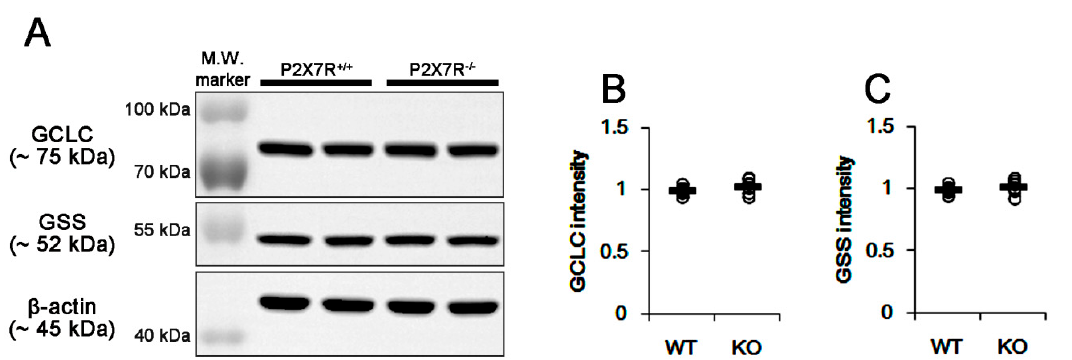
Figure 2. GSH assay in the hippocampus. P2X7R deletion decreases basal GSH level. NAC increases GSH level in WT animals but not P2X7R KO mice in vivo. Although SIN-1 does not affect GSH level in the hippocampal slices of both animals, it reduces GSH concentration to a basal level in NAC-treated WT animals but not P2X7R KO mice, ex vivo (mean ± S.E.M.; *, # p < 0.05 vs. WT animals and vehicle-treated animals, respectively; n = 7, respectively).